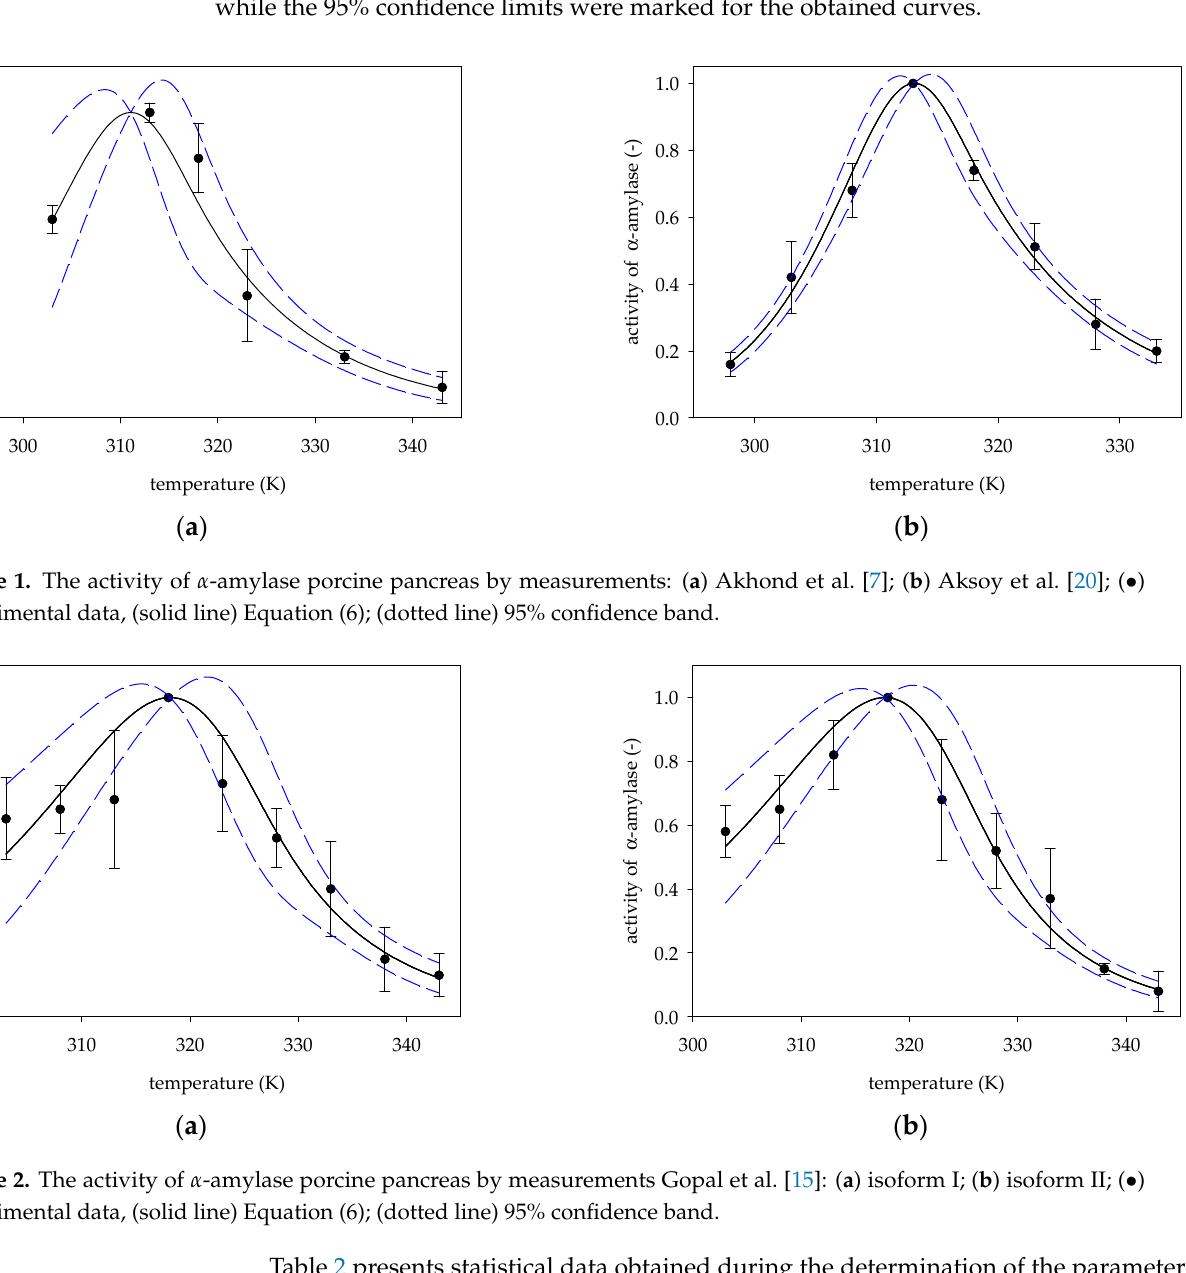
experimental data, (solid line) Equation (6); (dotted line) 95% confidence band.